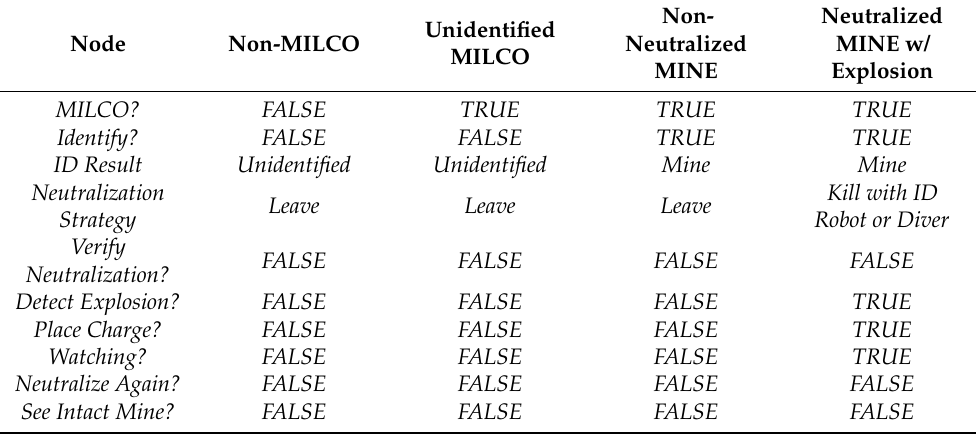
Table 3. State configurations for the nodes in the left column under a variety of common forms of evidence. That evidence represents the observations available within a particular grid